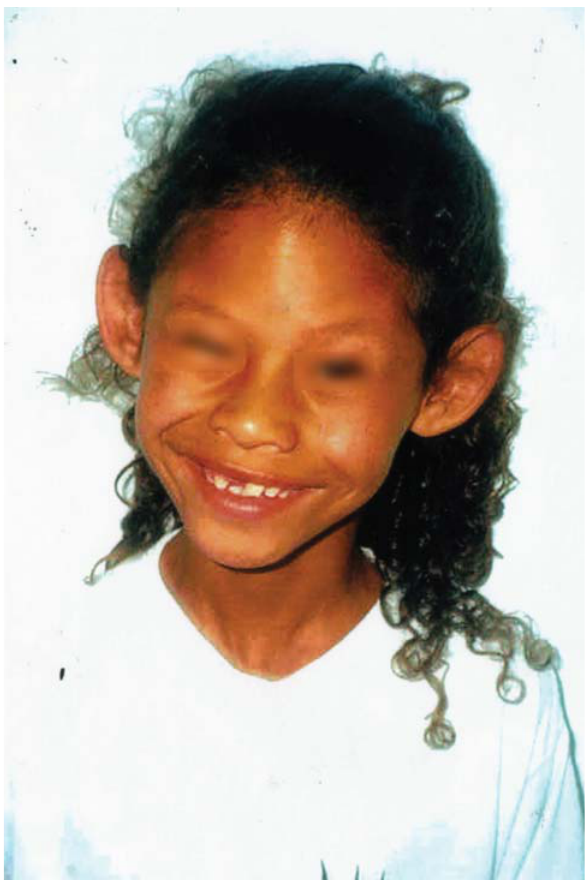
Figure 1 - Typical facial appearance of individuals with Williams Beuren syndrome (WBS): broad forehead, large and anteverted ears, flat nasal bridge, wide mouth, full cheeks, full prominent lips, dental anomalies, small jaw.